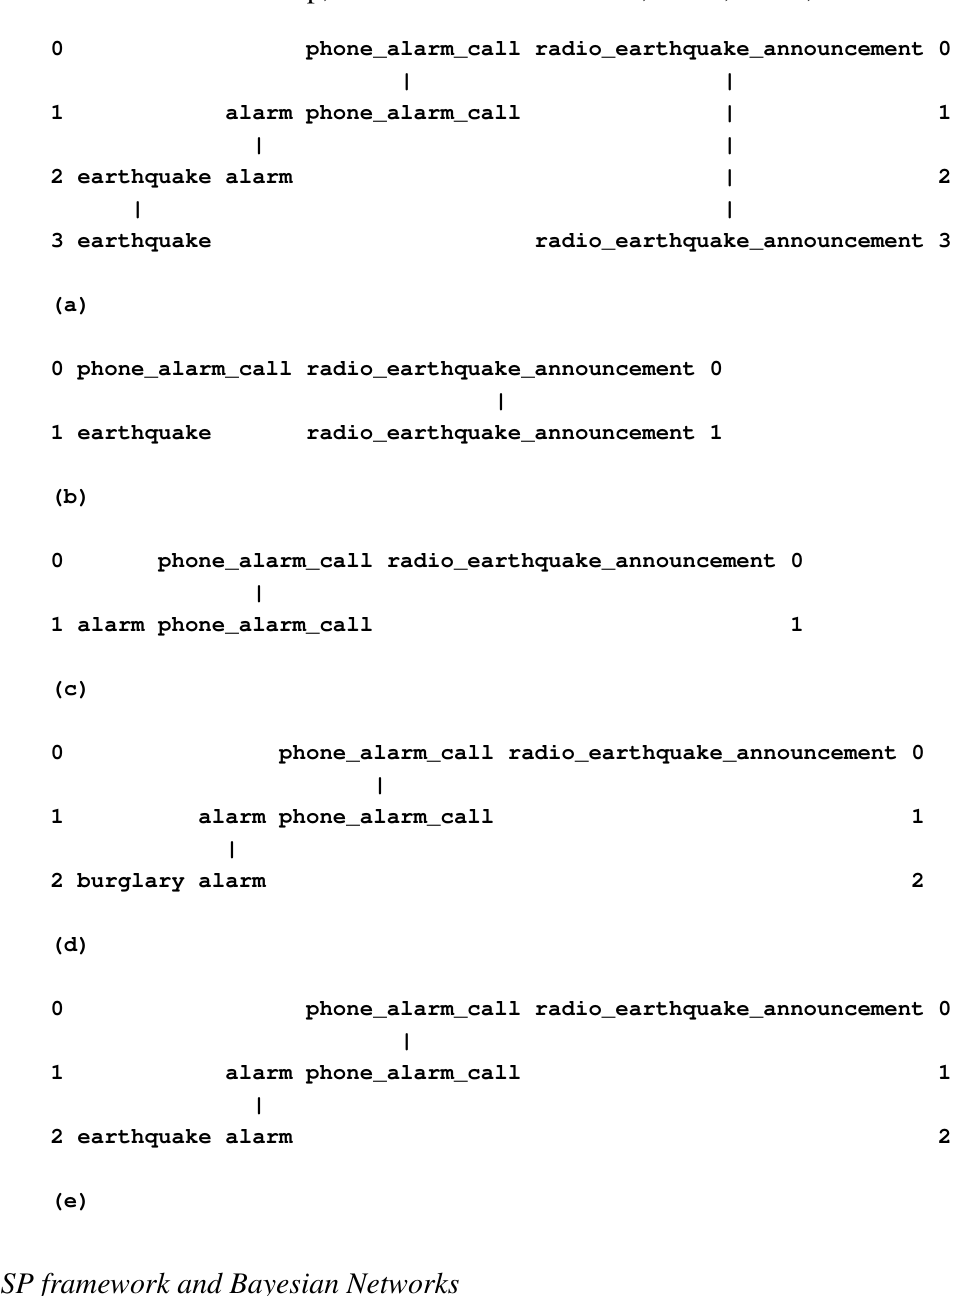
Figure 24. At the top, the best multiple alignment formed by the SP model with the pattern, “ phone alarm call radio earthquake announcement ”, in New and the patterns from Figure 22 in Old. Other multiple alignments formed by the SP model are shown below. From the top, the CD values are: 74.64, 54.72, 19.92, 18.92 and